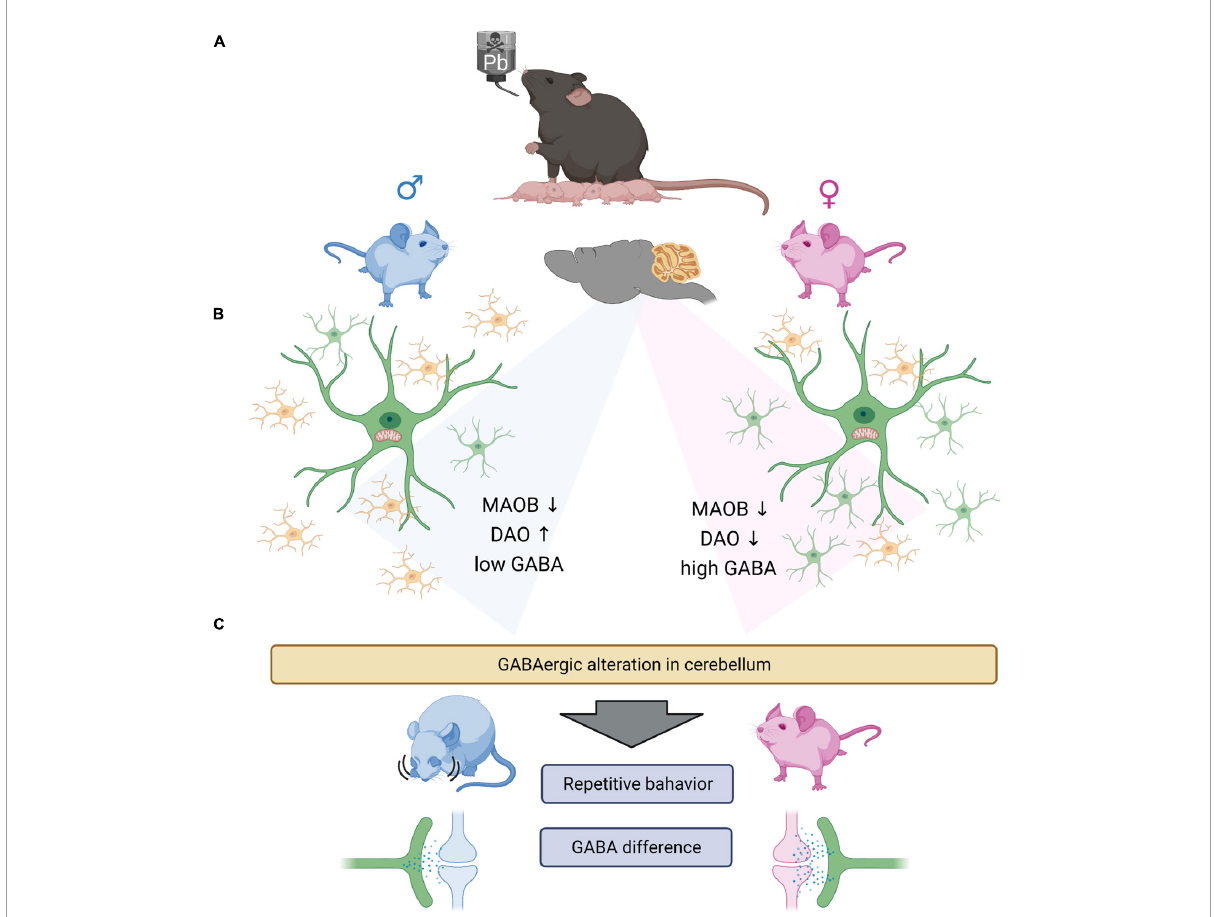
FIGURE7 Graphical summary. (A) Lead exposed offspring’s glial cells are having gliosis. Microgliosis (male) and astrogliosis (female). (B) GABA synthesizing enzymes, especially DAO is increased in male group and decreased in female group. However, MAOB is both decreased in male and female group both. From the experiments we observed the significantly low level of GABA in the male group, which we suggest that the low GABA level of male group need the complementation by DAO enzyme. Which we thought, there exists the minimum GABA level required to sustain the normal function of the brain. However, the basal GABA level is not induced by the astrocytosis in female group, as the control female group have significantly high level of GABA compared to the male group. (C) The change of GABA in cerebellum, could induce the repetitive behavior in male mouse and having no behavioral difference in female mouse. The difference of the behavioral differences are thought to be caused by the different GABA level between the sex. The low GABA level of male group are not rescued by the expression of DAO enzyme, with the exposure of the lead. However, as the female group have relatively high level of GABA, the lead exposure did not affect much to the behavioral changes of the female